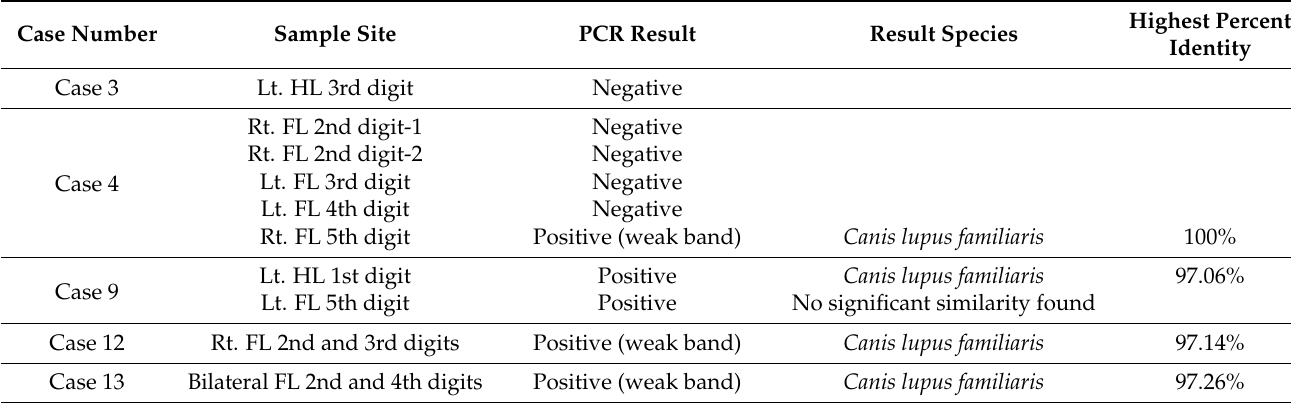
Table 4. PCR and BLAST results of hair remains in